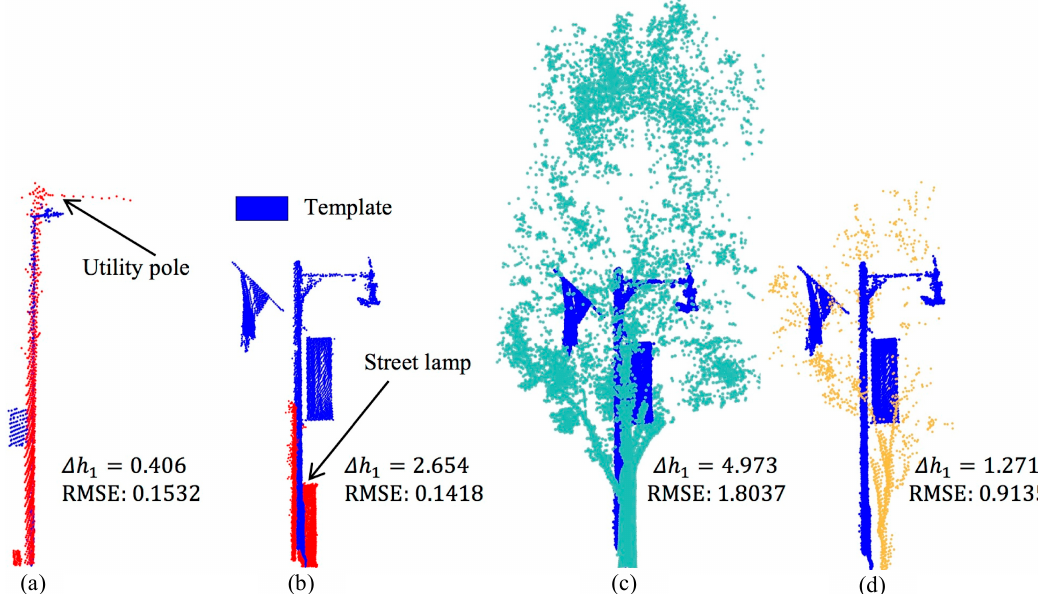
Figure 20. ( a ) Falsely classified utility pole as a street lamp; ( b ) Part of street lamp was misclassified as a traffic sign; ( c ) The big tree was classified as other object after matching the template; ( d ) The small tree was also classified as other object.